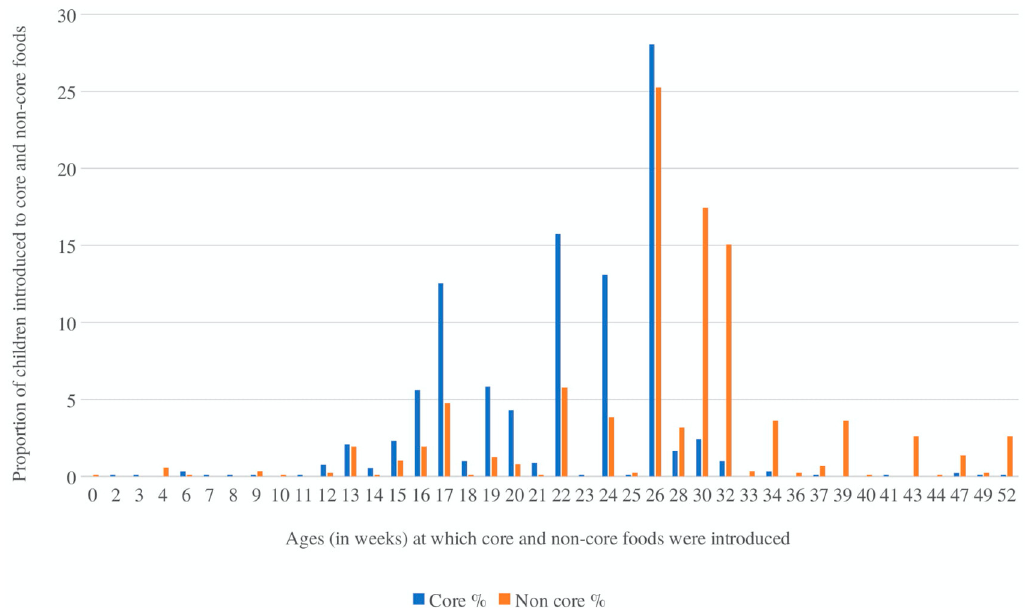
Figure 1. The distribution of age at which core and discretionary foods were first introduced.